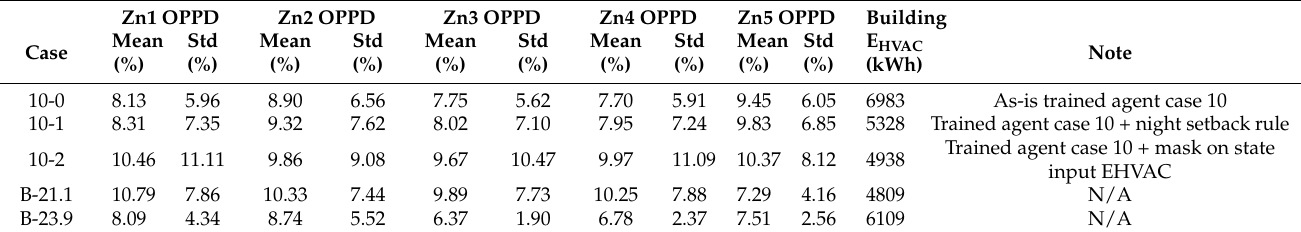
Table 7. The results of multizone testing in the training building model.